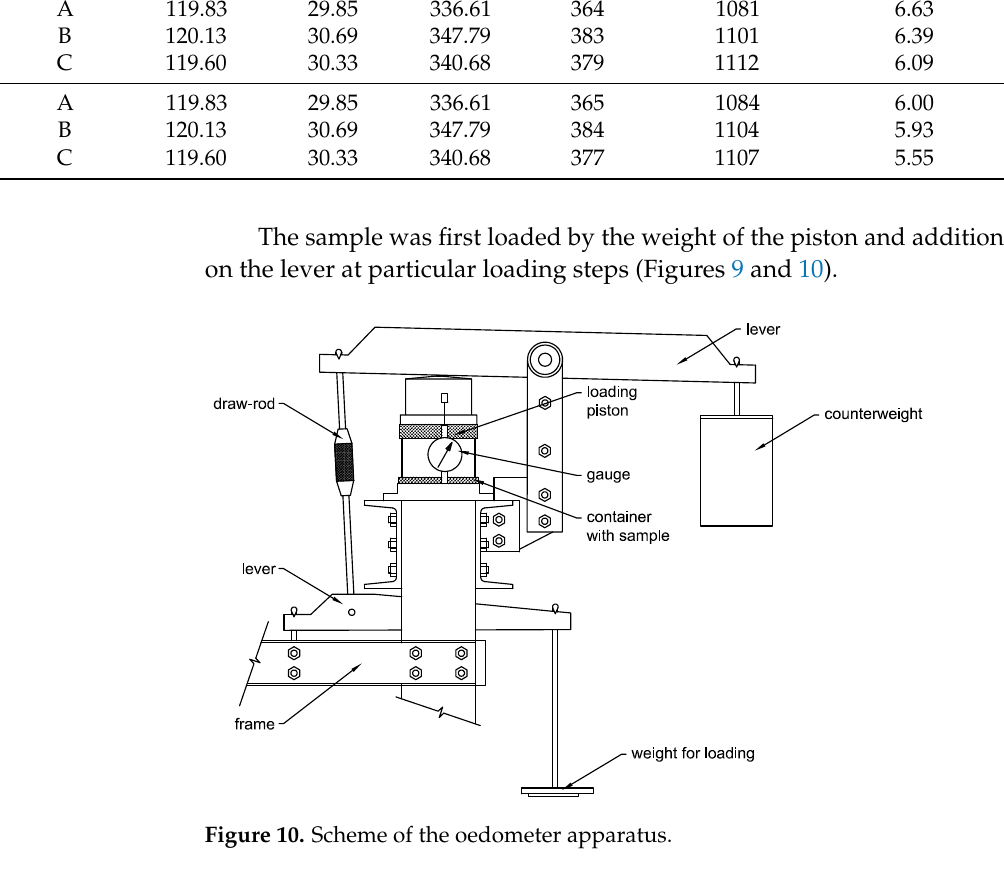
( b ) Figure 11. Sample of kinetic sand in the container of direct shear apparatus. ( a ) Original sample before testing; ( b ) Boiled sample before testing. The parameters of the sand samples are displayed in Table 5. A total of four samples of original and four samples of boiled kinetic sand were tested.